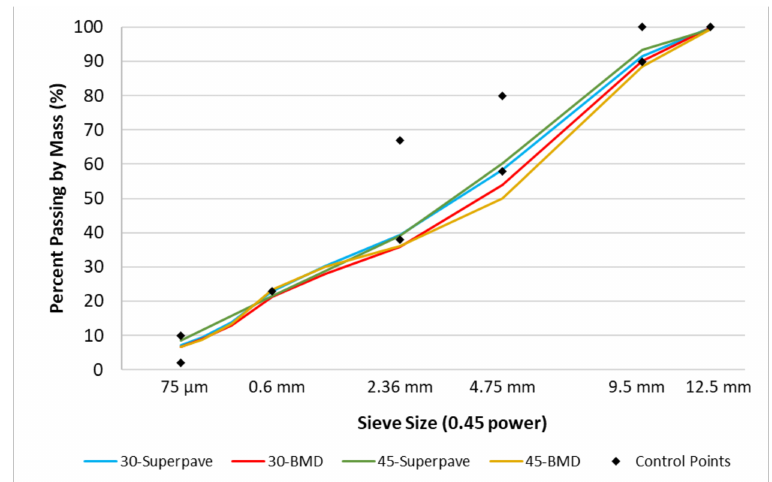
Figure 1. Gradation curves.